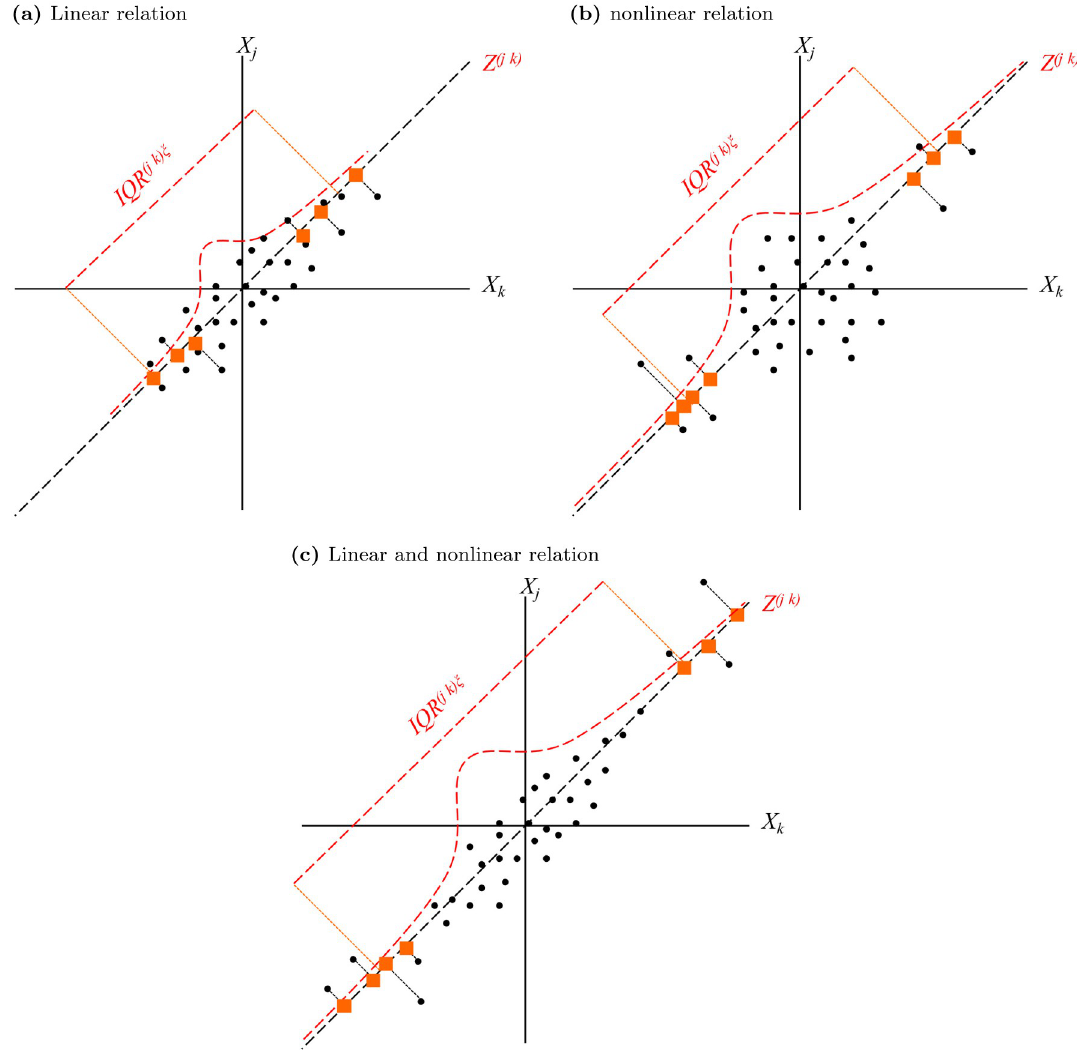
Fig 1. Diagrammatic representation of TailCoR. Scatter plots where X j and X k are positively related (the pairs are depicted with circles). Projecting the observations onto the ϕ - degree line produces the random variable Z ( jk ) , depicted with squares. Because of representation purposes we show the projection only for the observations on the tails but the reader should keep in mind that the projection is done for all the observations. Panel (a) shows the case of linear relation only. Panel (b) displays the case of nonlinear relation only. Panel (c) shows the scenario of both linear and nonlinear